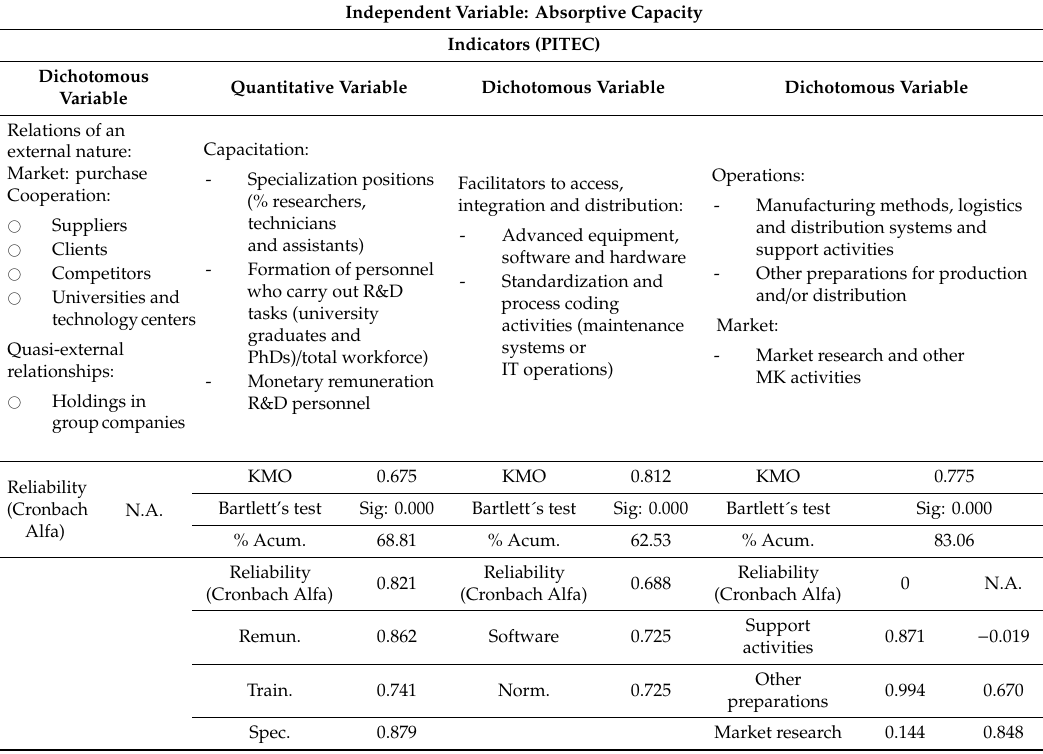
Table 1. Absorptive capacity: measurement